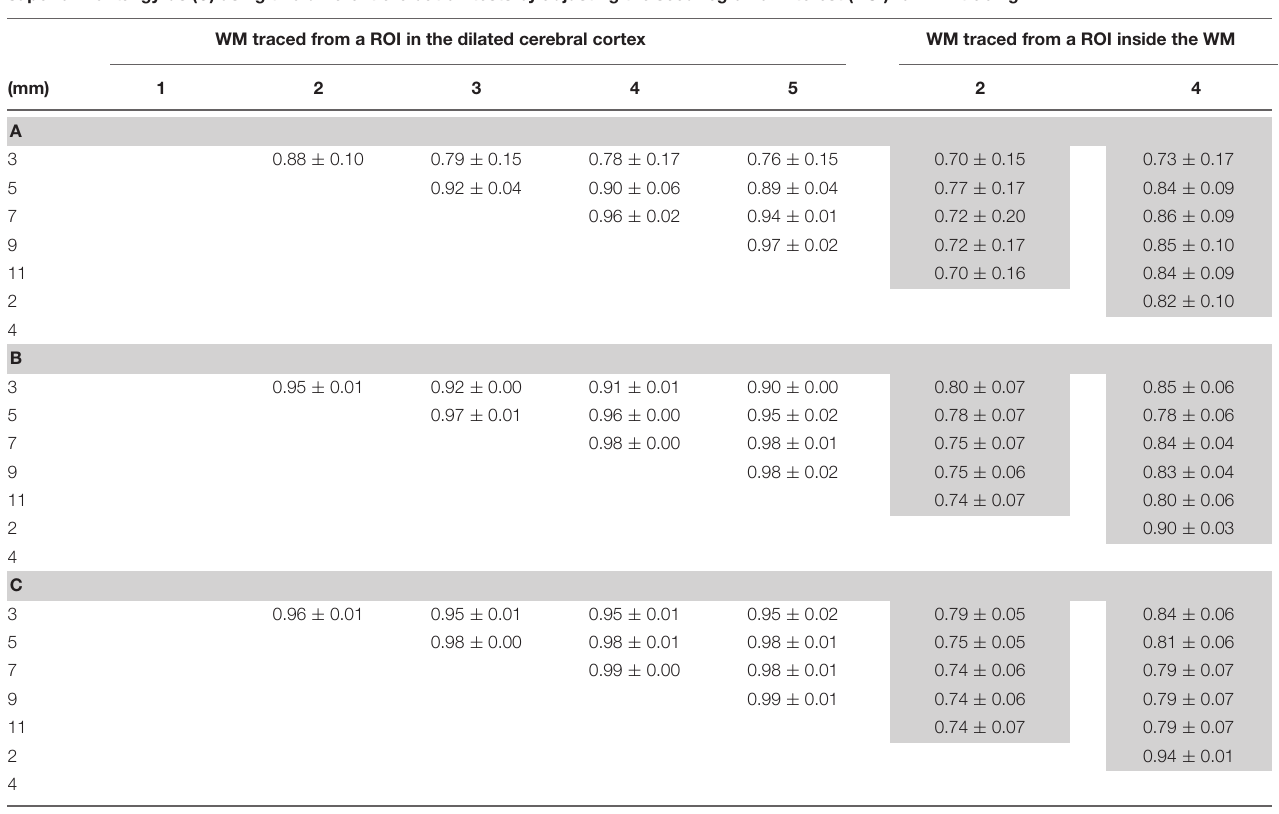
In the left five columns, mean Dice ratios and standard deviations are shown for a ROI from the cortex after being dilated by 1, 2, 3, 4, and 5 mm inward into the WM to initialize tracing. In the right two shaded columns, mean Dice ratios and standard deviations from a ROI at the interior WM are listed. The interior WM seed ROI was obtained by dilating a parcellated cortical gyrus by 2 and 4 mm into the WM, and subsequently subtracted by the corresponding cortical gyri dilated by 1 mm. Dice ratio results from three subjects with the representative ages (8, 16, and 25 years of age) spanning the age range in the present study were averaged.